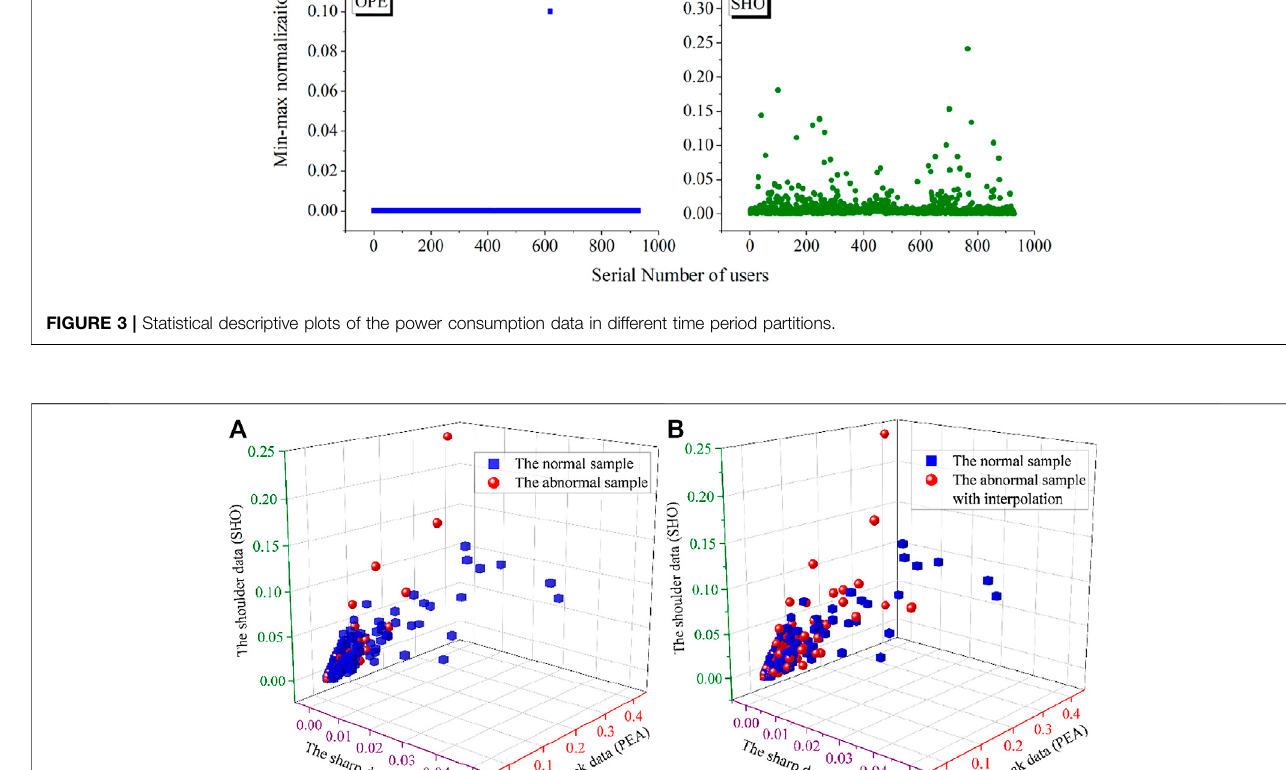
Frontiers in Energy Research |